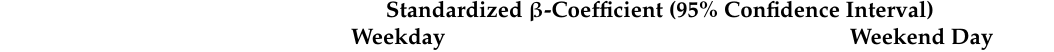
Table 4. Multilevel linear mixed models stratified by weekday/weekend for associations between physical activity, sedentary time, and sleep parameters.